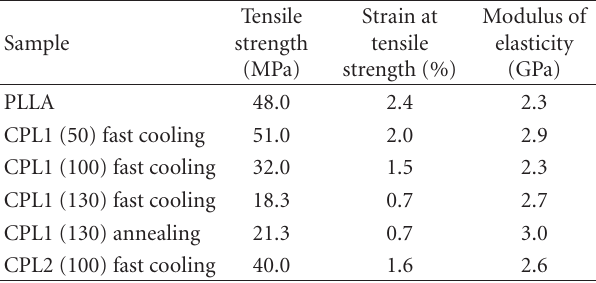
Table 2: Tensile properties of the films of neat PLLA and chitosan- PLLA blends treated in extruder at various